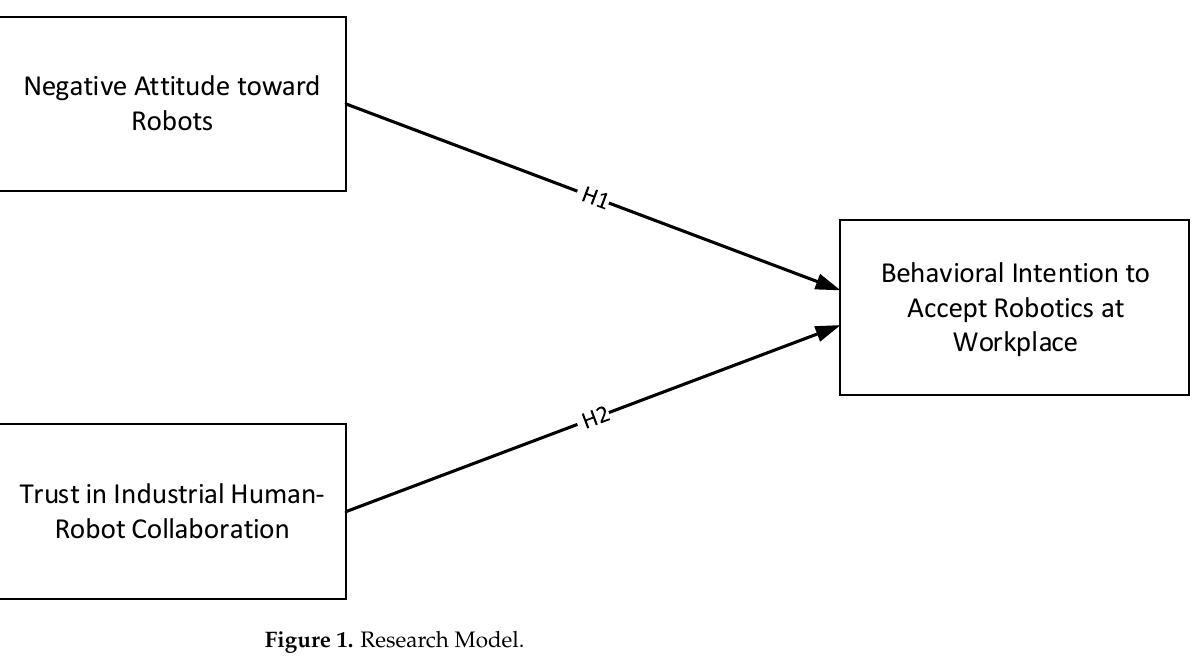
Figure 1. Research